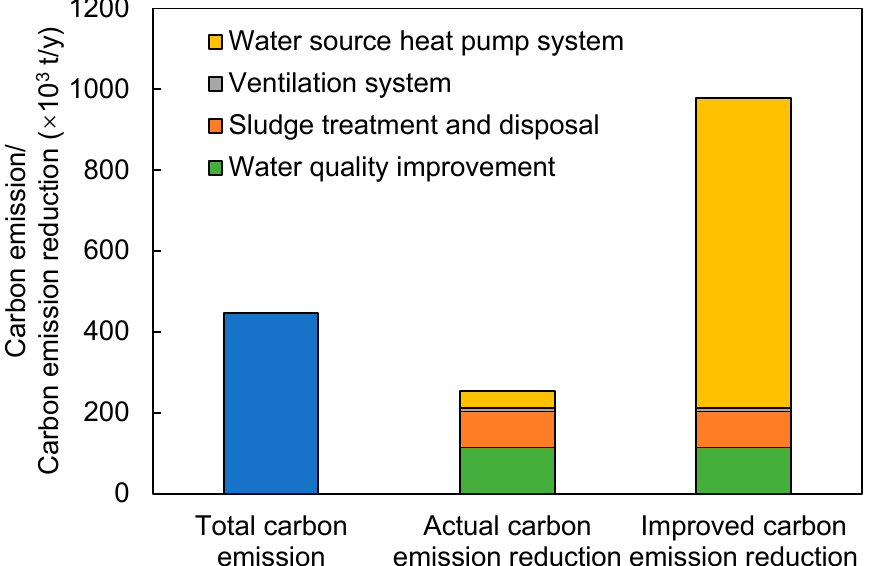
Figure 4. Carbon emission, actual carbon emission reduction, and improved carbon emission reduc- tion after the complete extraction of heat from the secondary effluent in Gaobeidian WWTP. Table 9. Carbon footprint